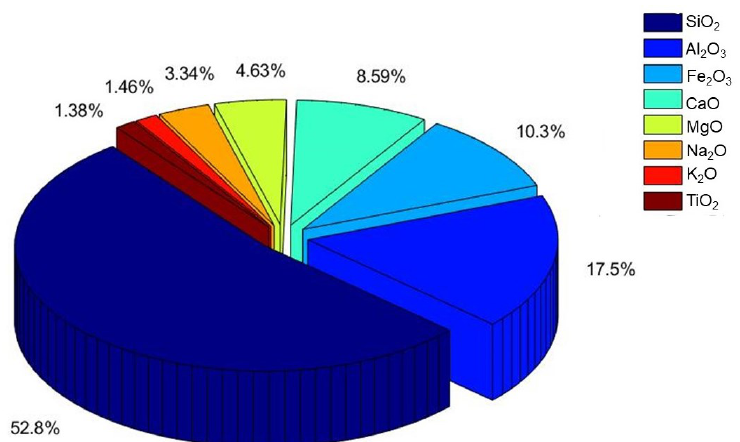
Figure 1. Composition of basalt may vary depending on the extraction site, it may also include small quantities of other oxides such as P 2 O 5 , MnO and Cr 2 O 3